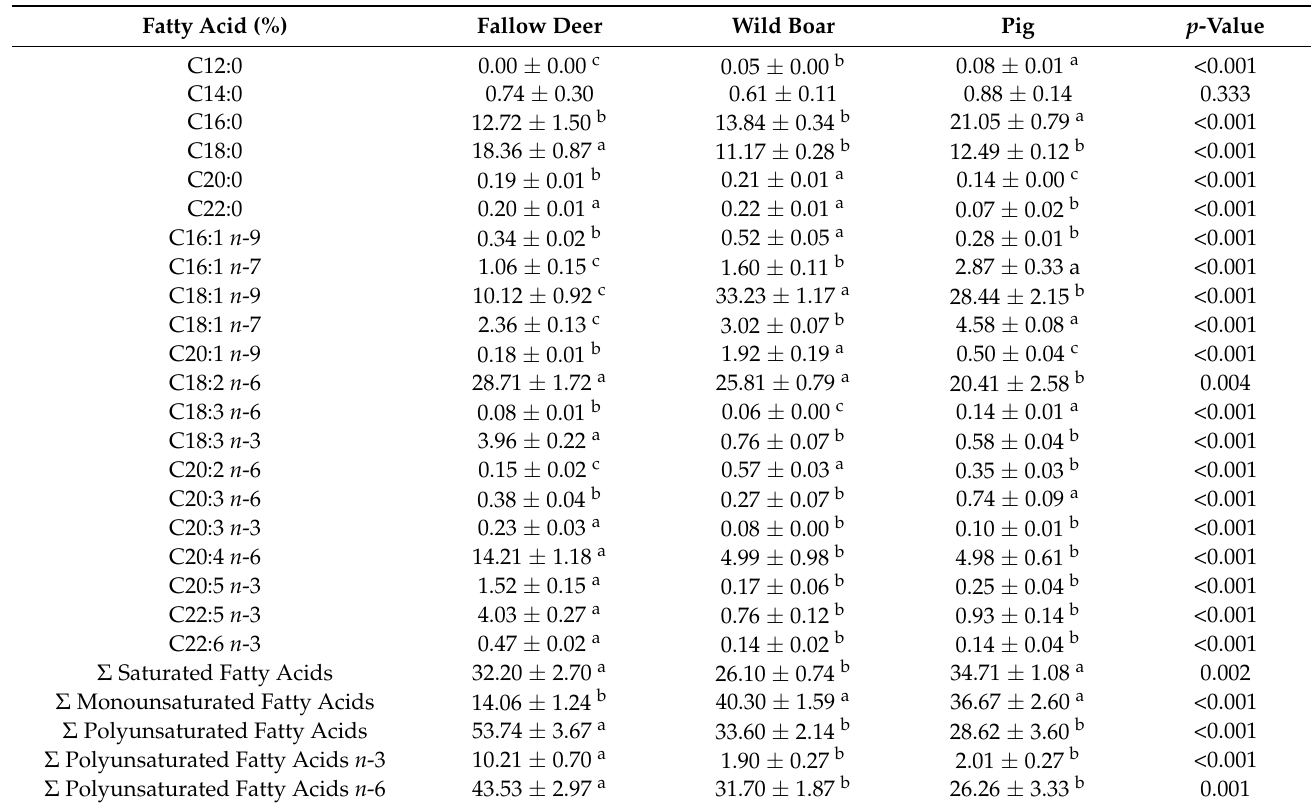
Table 4. The results of the fatty acid profile determination of thigh meat samples (%/total fatty acid; mean ±